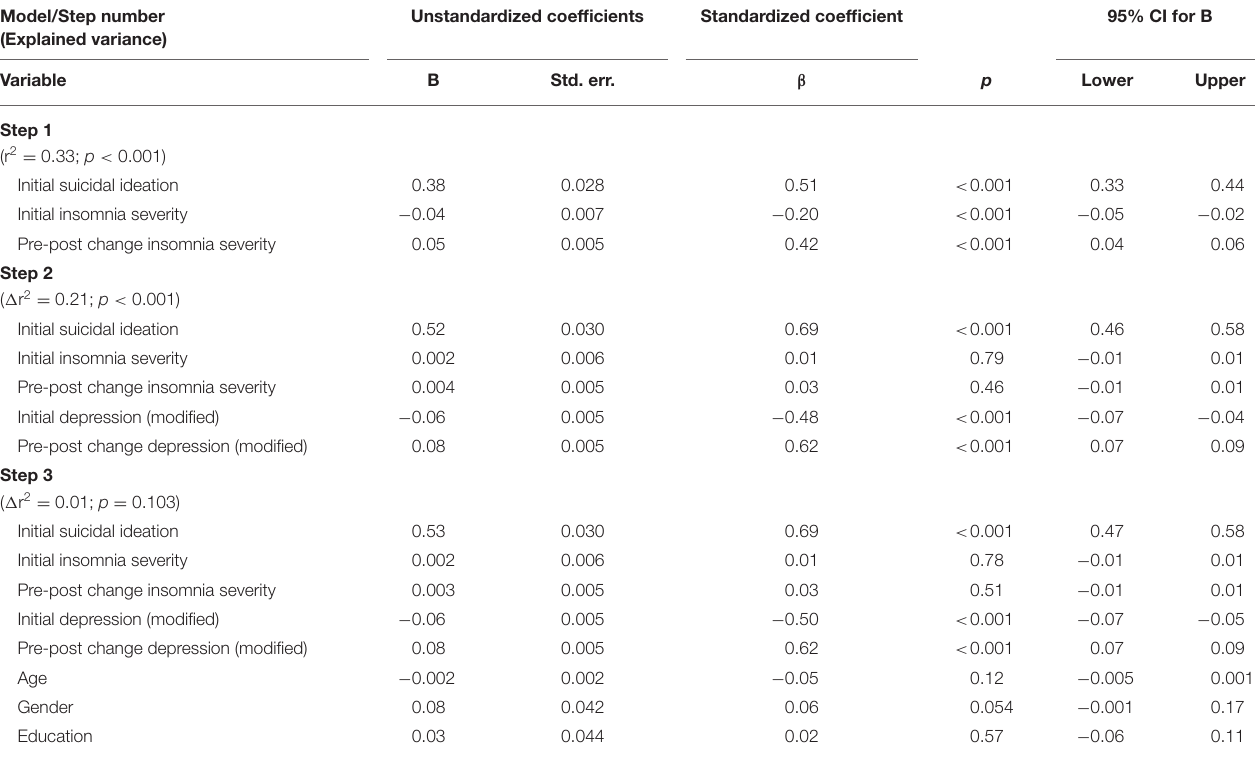
TABLE 4 | Prediction of decrease in suicidal ideation from pre- to post-treatment. Model/Step number (Explained